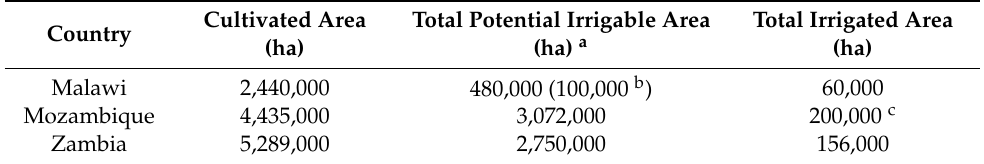
Table 1. The cultivated, potential irrigable and actual areas under irrigation in Malawi, Mozambique and Zambia. Total Irrigated Area Cultivated Area Total Potential Irrigable Area Country (ha) (ha) (ha) a Malawi 2,440,000 480,000 (100,000 b ) 60,000 Mozambique 4,435,000 3,072,000 200,000 c Zambia 5,289,000 2,750,000